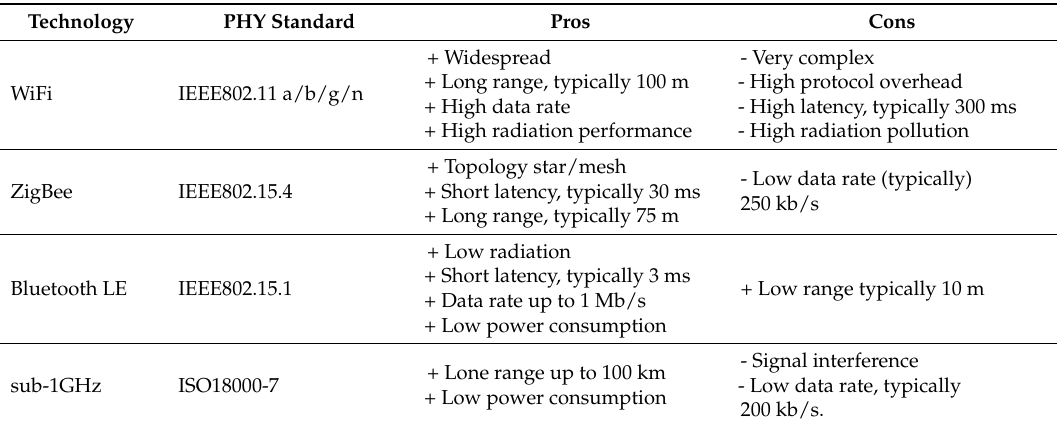
Table 3. Use case II : A comparison of the communication technologies to interconnect the